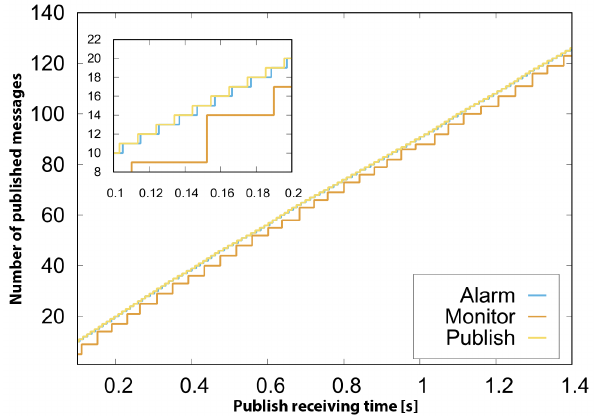
Figure 6. Publish messages receive